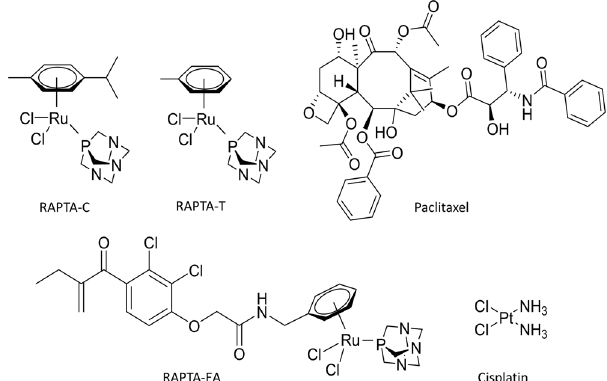
Figure 1. Anti-cancer compounds mentioned in this